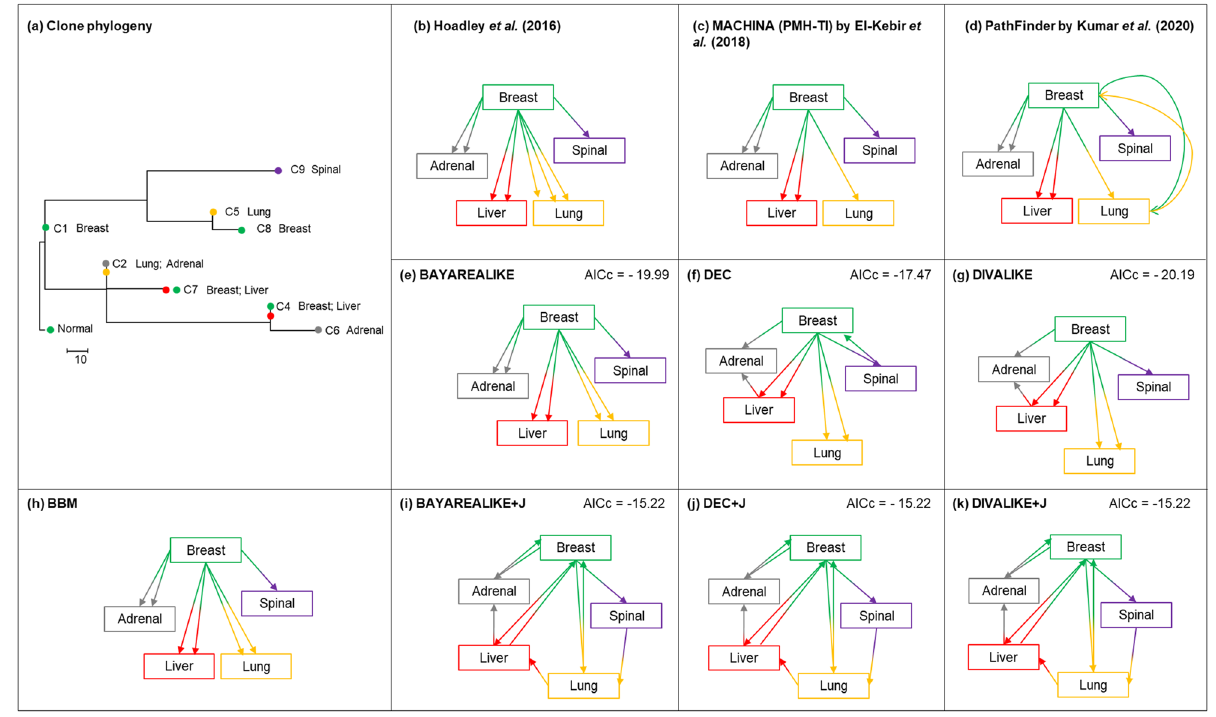
Figure 7. Analysis of Patient A1 with basal-like breast cancer 13 . ( a ) Clone phylogeny and tumor location of each clone reported in the original study. ( b – k) Clone migration histories predicted by non-biogeographic and biogeographic models. Colors correspond to the tumor location where clones were sampled from. Values on the top right are